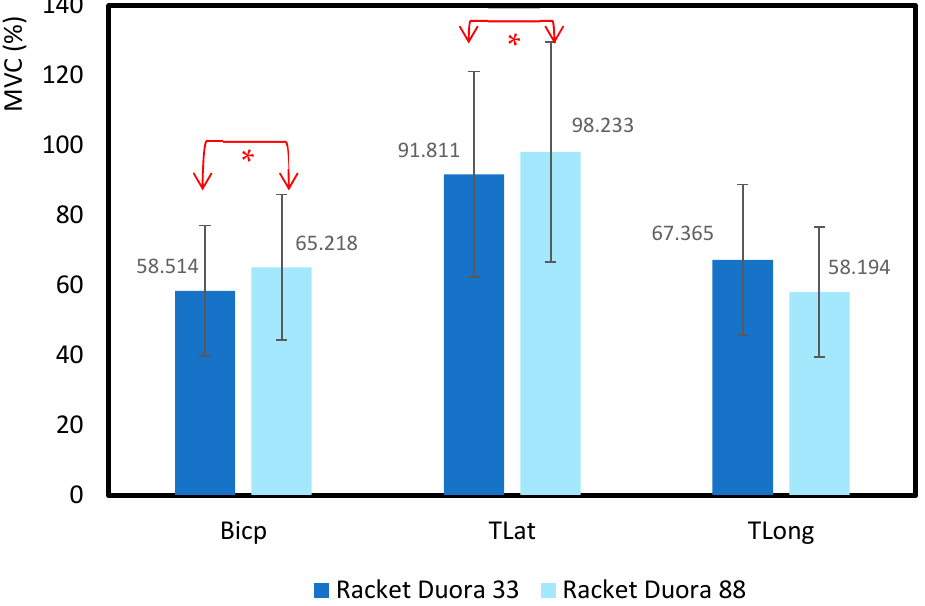
Figure 6. Average of the normalized intermuscular amplitude (%MVC) and their standard deviation. Statistically significant values are highlighted in the figure with an asterisk.